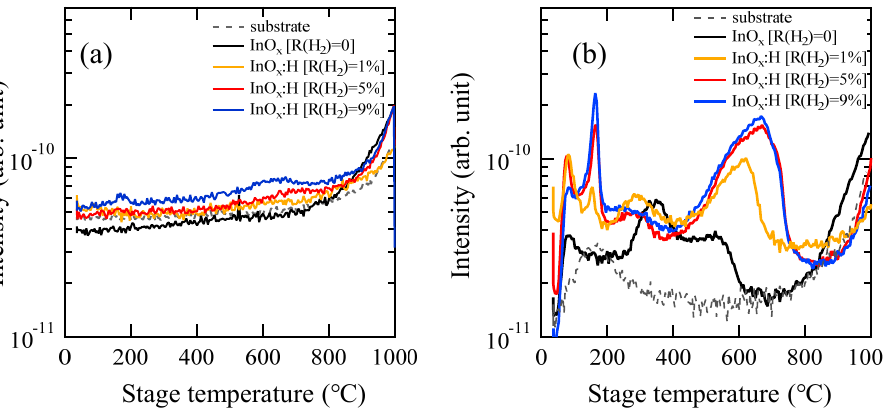
Figure 6. TDA spectra of ( a ) m / z = 2 (H 2 ) and ( b ) m / z = 18 (H 2 O) obtained from as-deposited InO x [R(H 2 ) = 0] and InO x :H [R(H 2 ) = 1, 5, 9%] films.